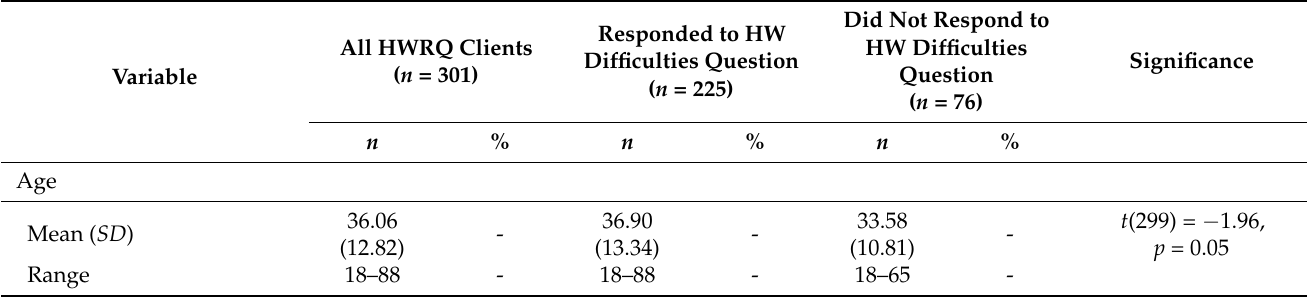
Table 1. Pre-treatment patient characteristics by